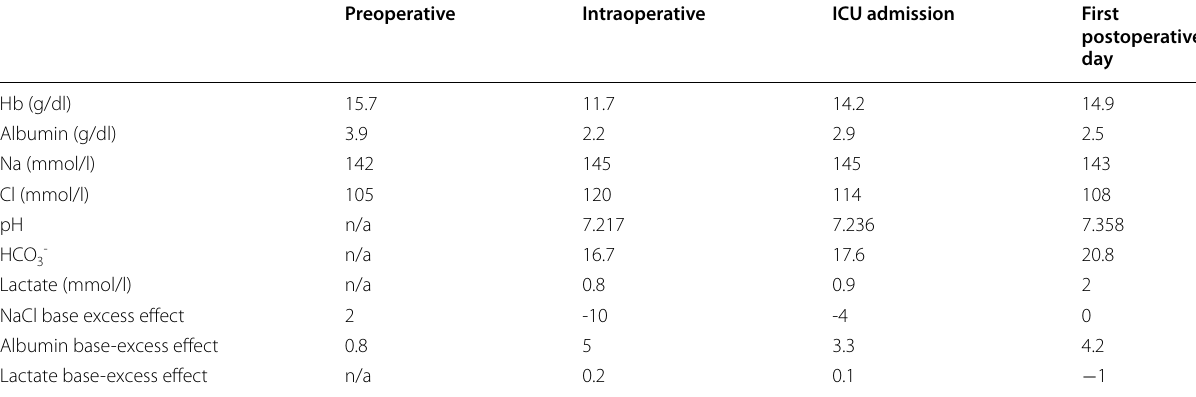
n/a not available Hemoglobin, albumin, Na, and Cl levels were measured at the central laboratory, while other parameters were analyzed using a blood gas analyzer (Cobas B221, Roche Diagnostics, Basel, Switzerland). NaCl base excess effect, [Na + ]-[Cl - ]-35 (mEq/l); albumin base excess effect, 0.25X(42-Alb (g/l)) (mEq/l); lactate base excess effect, 1-Lactate (mmol/l) (mEq/l) (from reference